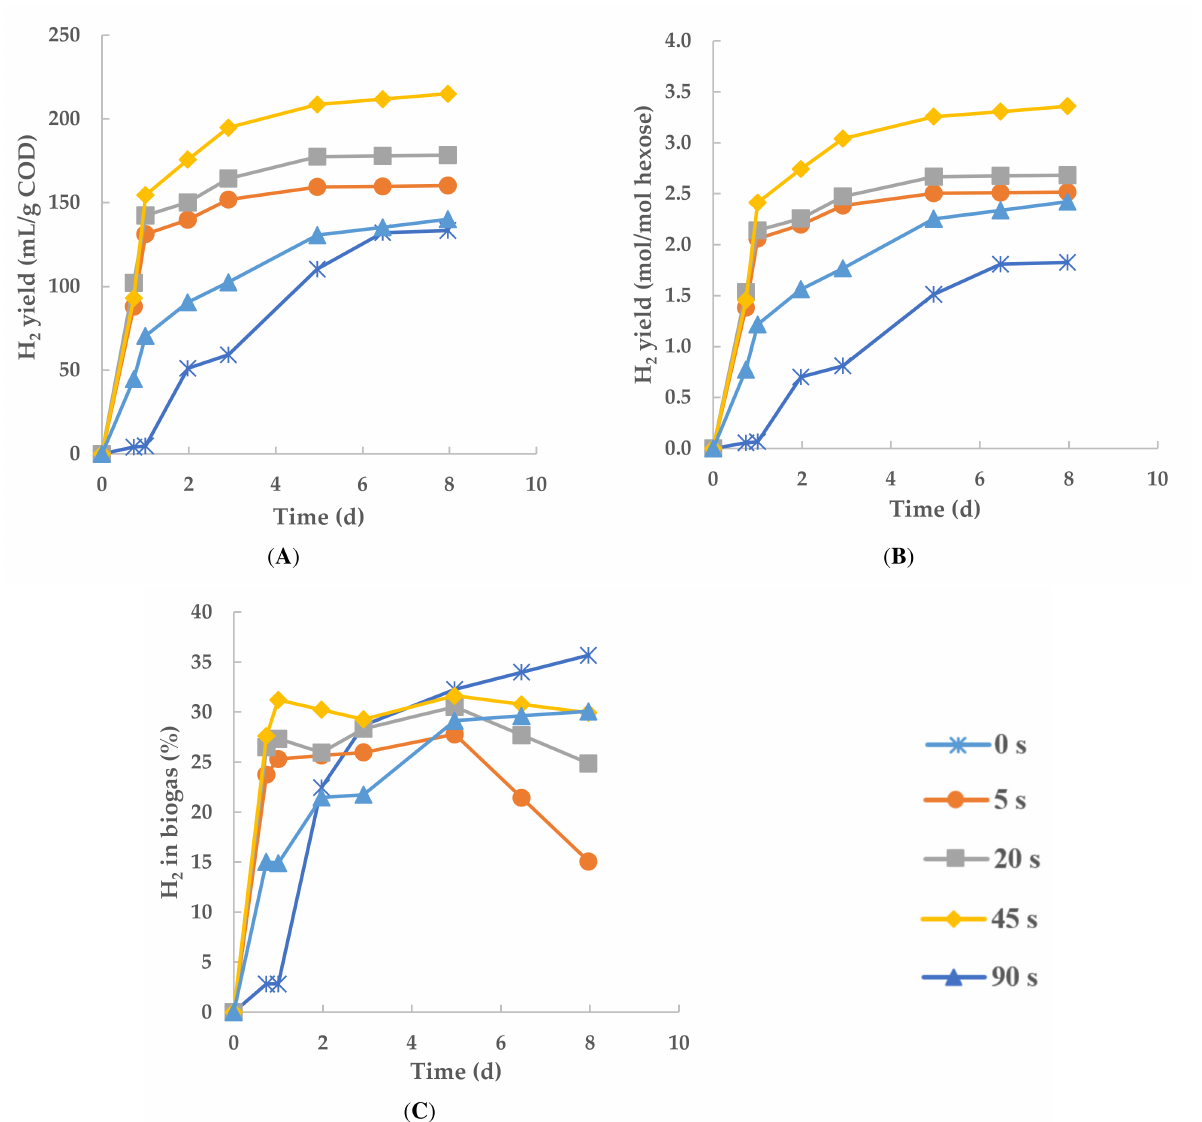
Figure 4. Dynamics of the cumulative hydrogen production per g COD ( A ) and mol of hexose ( B ), and hydrogen concentration in biogas ( C